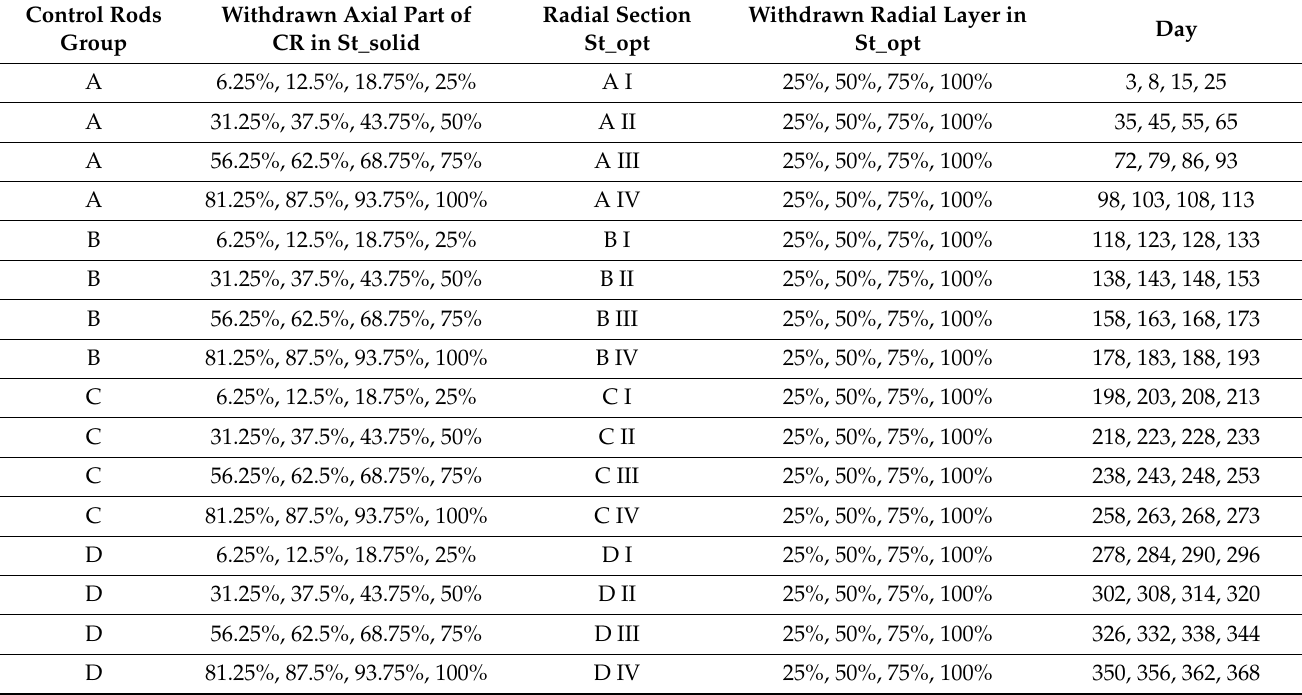
Table 5. Specification of St_solid and St_opt control rod operation strategies in a refined timestep simulation scheme. Control Rods